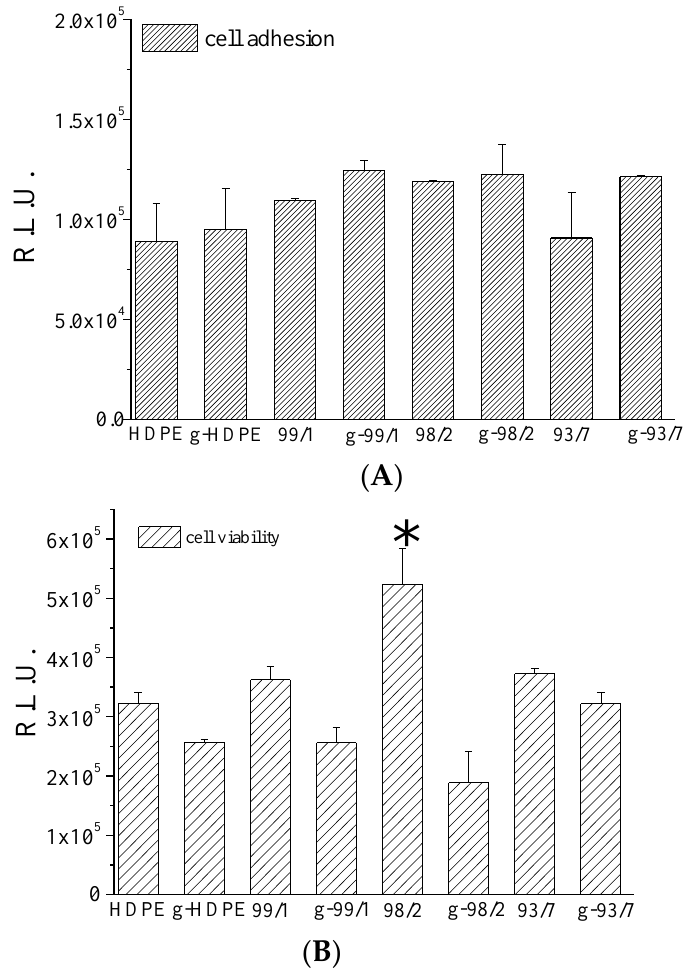
Figure 5. Adherent fibroblast per field at 10 min ( A ) and the viable cells after 24 h ( B ) of HDPE/ATZ composites grafted with chitosan. The code “g” indicates samples functionalised with chitosan. * means statistical significance.